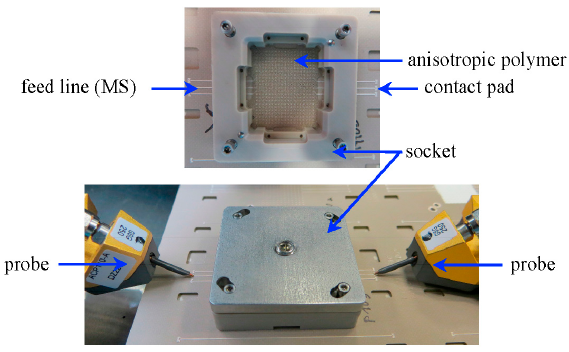
Figure 28. PCB to chip transition with test socket and ACP as temporary microwave interconnect (Adapted with permission from [6], IEEE, 2017).